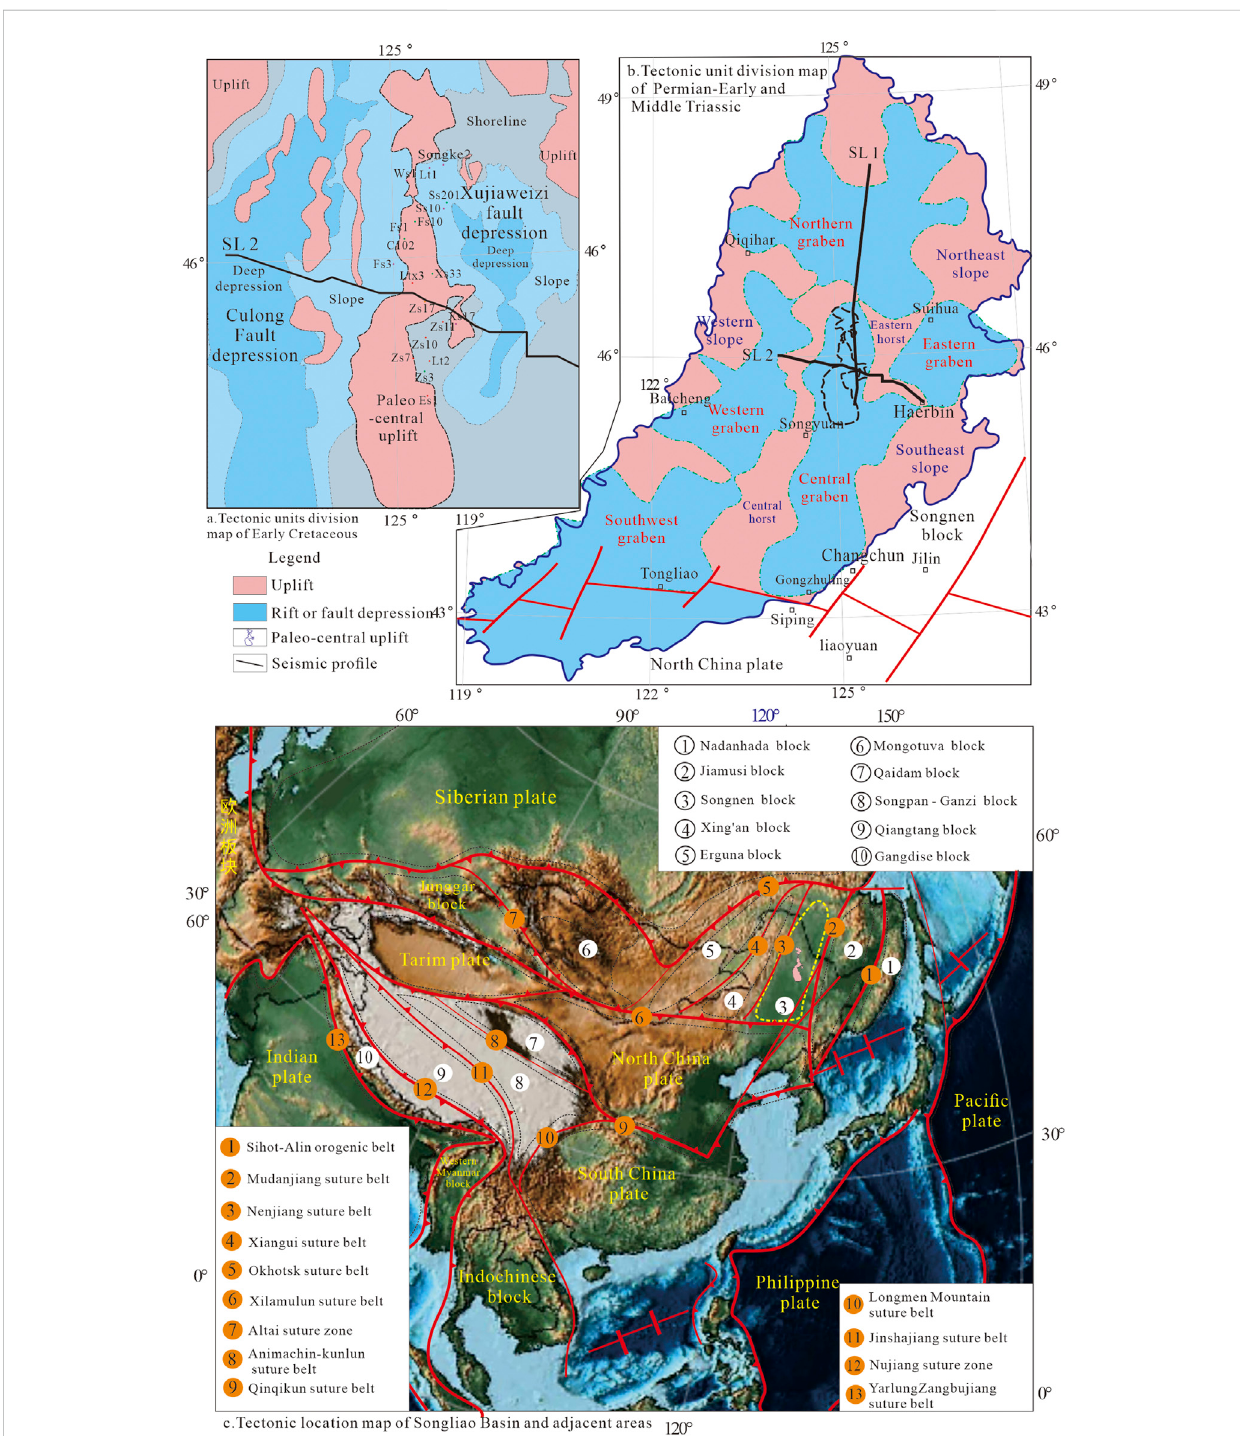
FIGURE 1 Structural characteristics and tectonic setting of Songliao Basin. Paleogeographic maps modi fi ed from Scotese (2016).